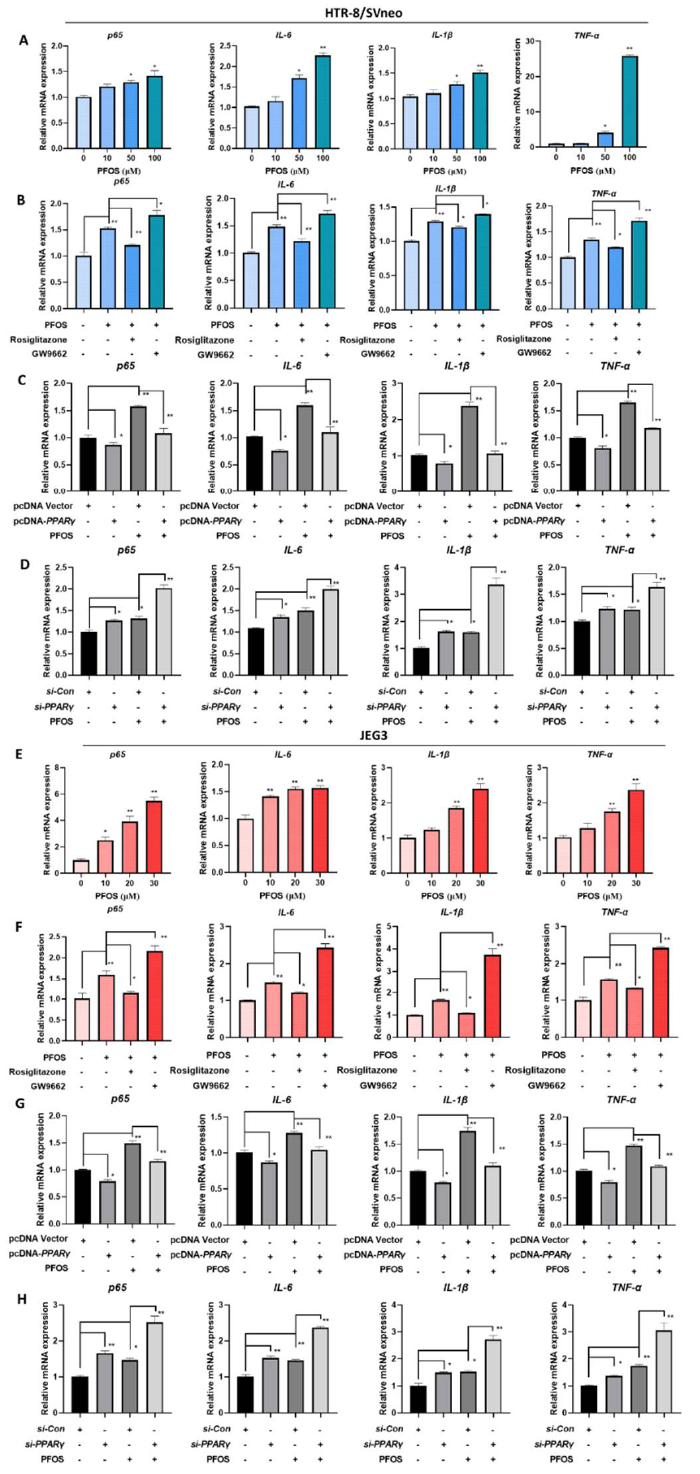
Figure 6. PFOS alters mRNA level of PPARγ target genes associated with inflammatory cytokines. The mRNA expression was analyzed by RT-PCR in HTR-8/SVneo and JEG-3 cells were exposed to PFOS for 24 h ( A , E ), in the absence or presence of rosiglitazone and GW9662 ( B , F ), with PPARγ overexpression ( C , G ) and knocking down ( D , H ) in HTR-8/SVneo and JEG-3 cells. The data are shown as the means ± S.E.M. * p < 0.05; ** p < 0.01; compared with the indicated group, n =